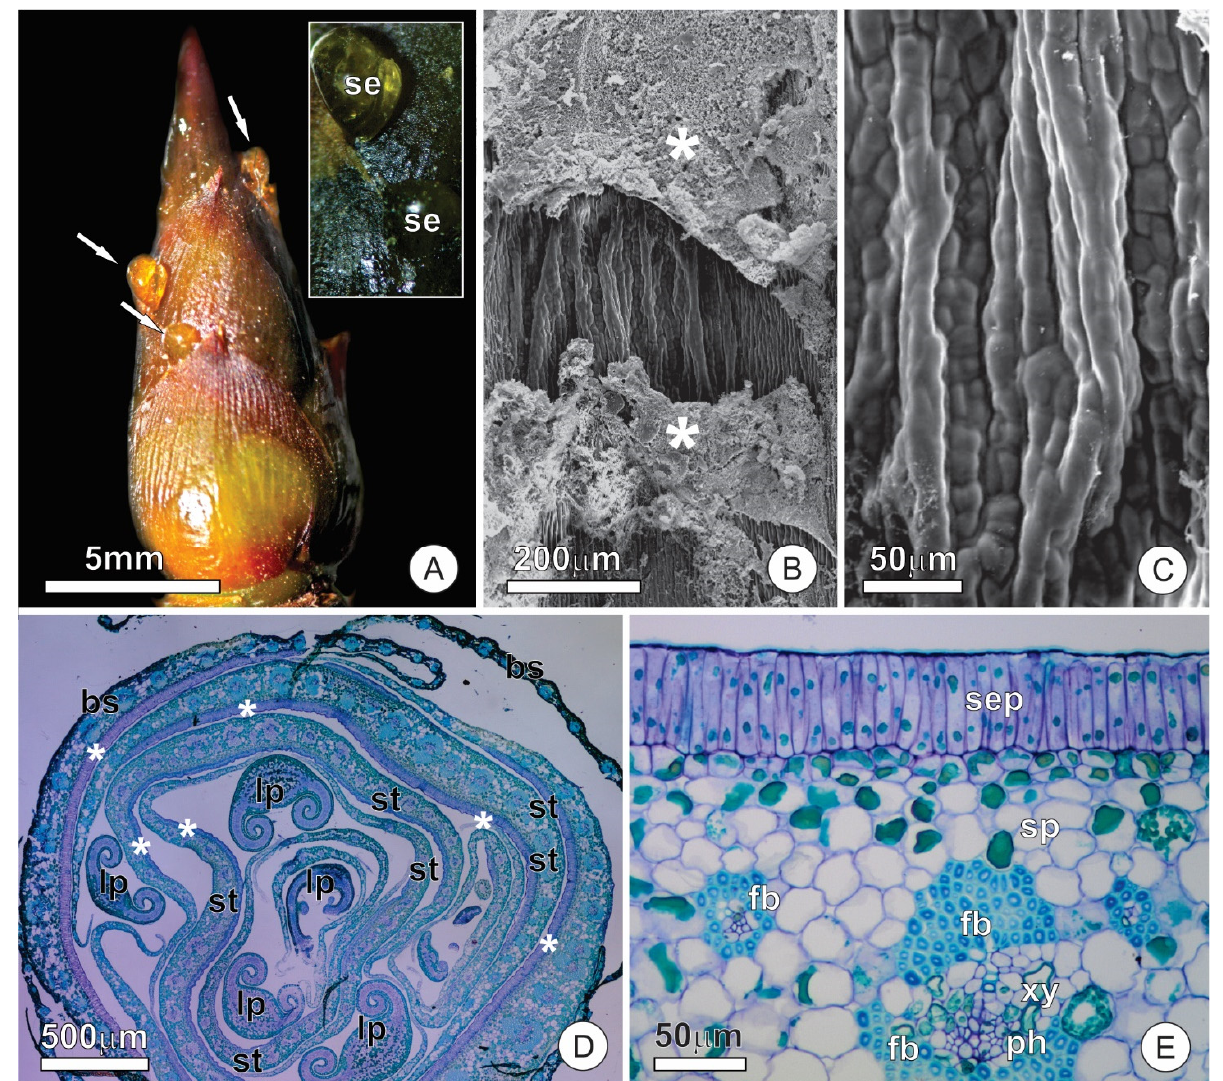
Figure 1. Resin glands of bud scales and stipules of O. castaneifolia : ( A ) Vegetative bud showing resin accumulation on the surface of bud scales (arrows). The insert shows released secretion towards the abaxial side of the bud scales; ( B – C ) The surface of resin-glands showing corrugated aspect and secretion residues (*). ( D ) Cross-section of a bud showing an overlapped arrangement of bud scales, stipules, and leaf primordia. Note the distinct epidermis at the abaxial face of bud scales and stipules (*); ( E ) Cross-section of a stipule showing adaxial secretory epidermis and the overall arrangement of the mesophyll and vascular tissue. Note the fiber cap that surrounds the vascular bundles; bs = bud scale, fb = fiber cap, lp = leaf primordium, ph = phloem, se = secretion, sep = secretory epidermis, st = stipule, xy = xylem.